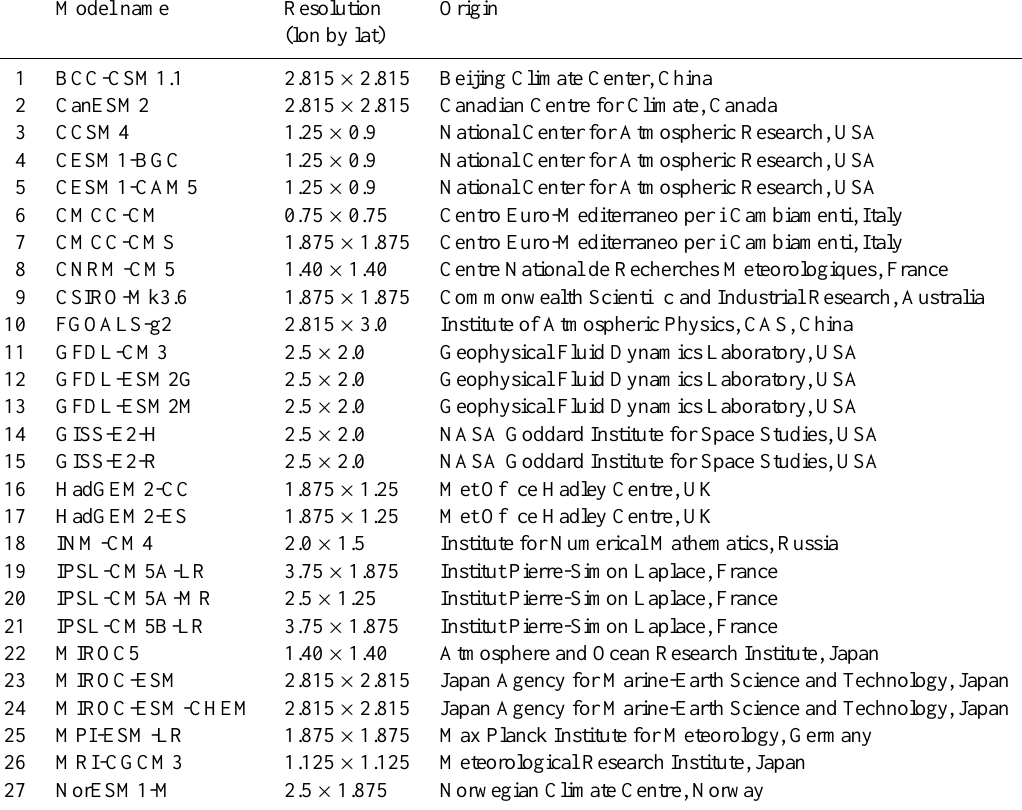
Table 1. A list of CMIP5 GCMs used in this study with a brief description. The historical run (1850–2005) and two future scenario (RCP4.5 and RCP8.5) runs (2006–2100) from each model are used. The first ensemble run is used if a model has multiple ensemble